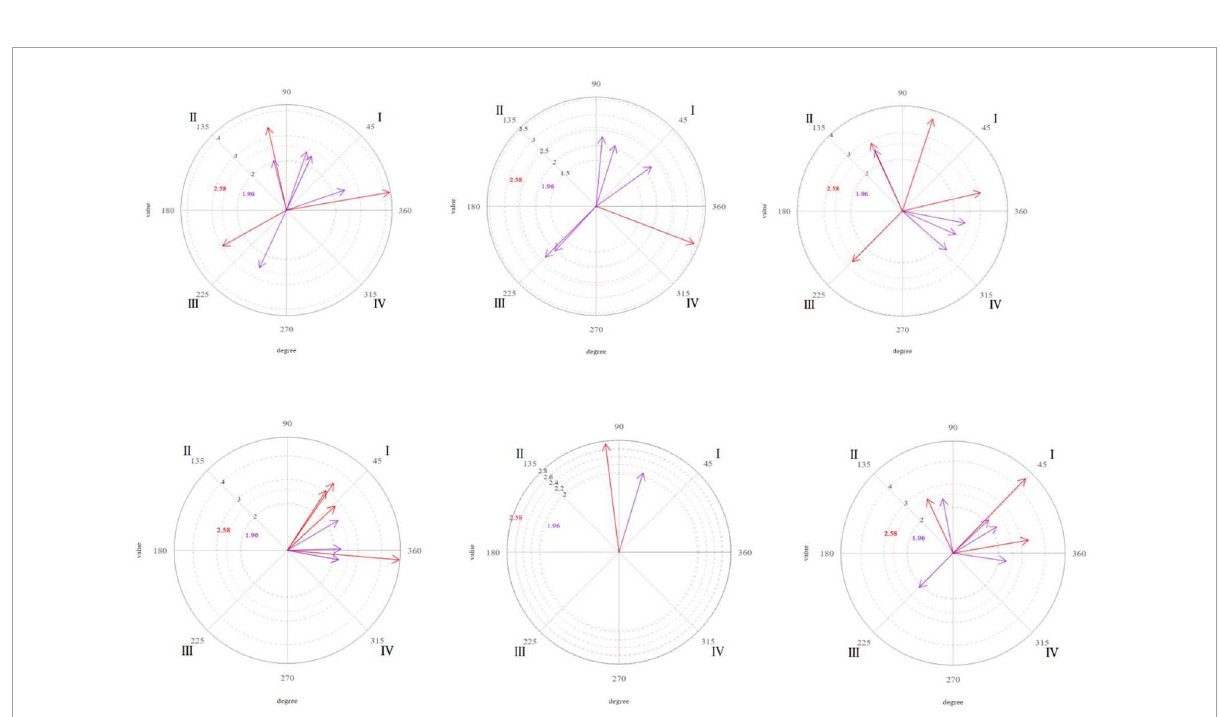
FIGURE3 Graphic representation of the significant (purple) and very significant (red) vectors obtained in the polar coordinate analysis. Focal behavior “Stimulates” as the center of the analysis and all the others as conditional of sessions 9, 16, and 20 (from left to right). Focal behavior “Facial expression” as the center of the analysis and all the others as conditional of sessions 9, 16, and 20 (from left to